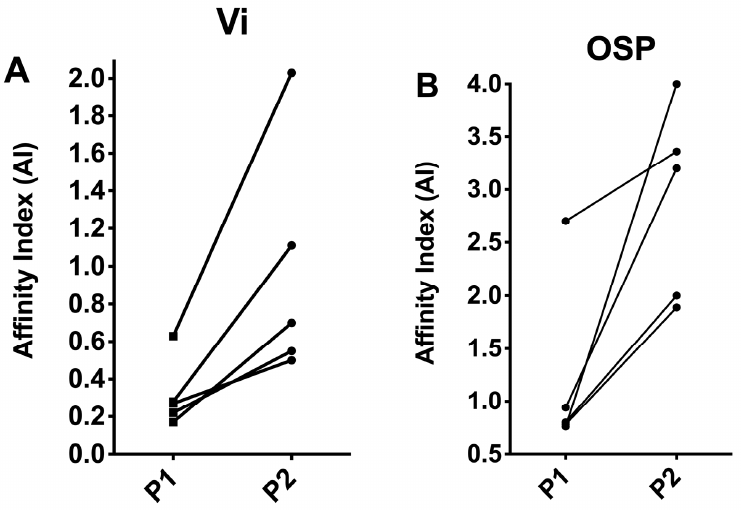
Figure 6. Affinity maturation of Vi ( A ) and OSP ( B ) antibodies. Affinity index was calculated as described in the “Materials and Methods” section.